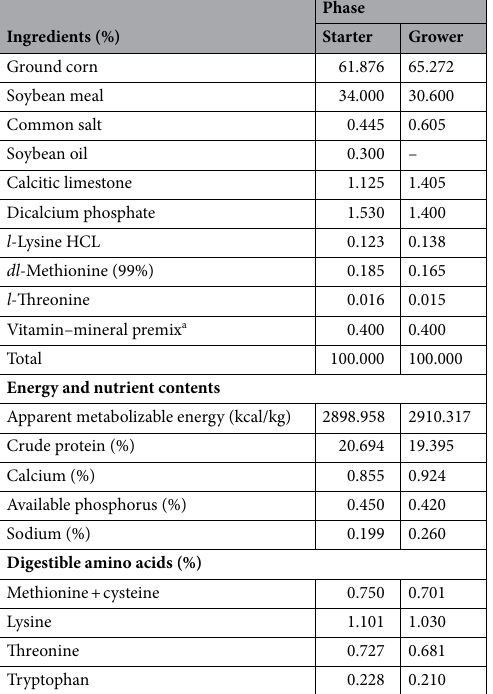
Table 7. Composition and nutrient content of starter (1 to 14 days of age) and grower (15 to 35 days of age) diets for Japanese quail ( Coturnix coturnix japonica ) chcicks. a Provided per kg of product: 2,270,000 IU vitamin A, 6330 IU vitamin E, 561 mg vitamin B1, 1490 mg vitamin B2, 858 mg vitamin B6, 3500 mcg vitamin B12, 450 mg vitamin K3, 2976 mg calcium pantothenate, 8820 mg niacin, 200 mg folic acid, 20 mg biotin, 86 mg choline, 19 mg zinc, 14 mg iron, 20 mg manganese, 3040 mg copper, 290 mg iodine, 50 mg cobalt, 88 mg selenium, 25 mg ethoxyquin, and 20 mg butylated hydroxyanisole